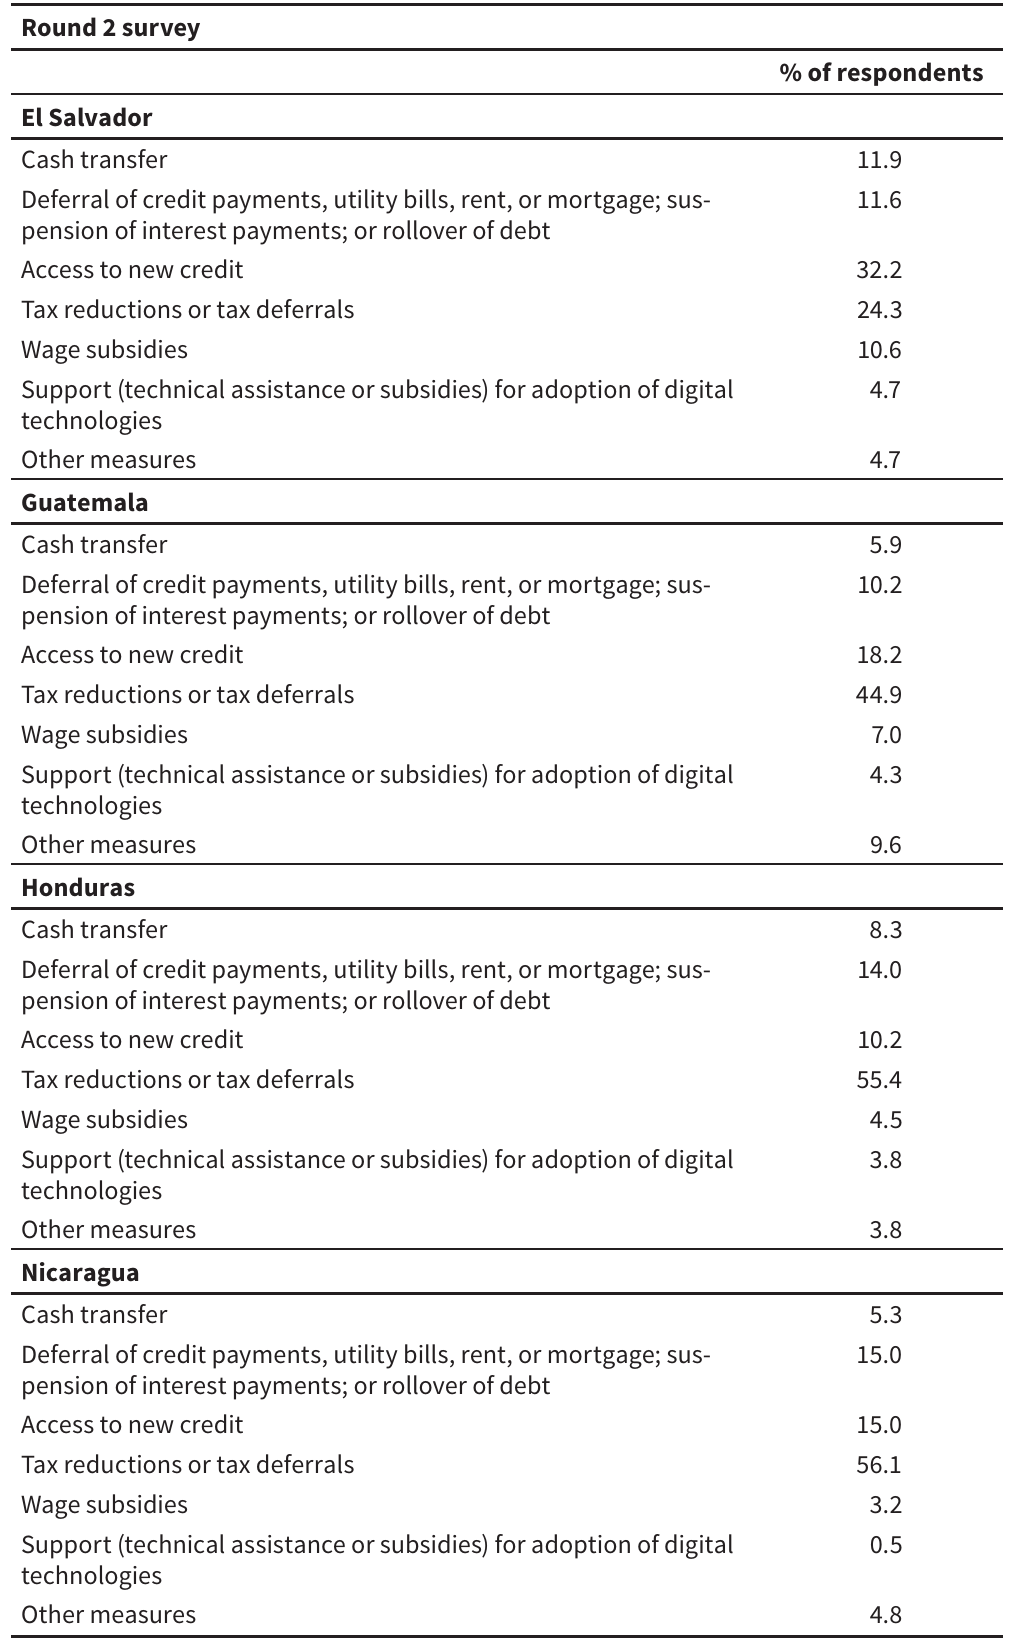
What would be the most-needed government measures to support this business over the COVID-19